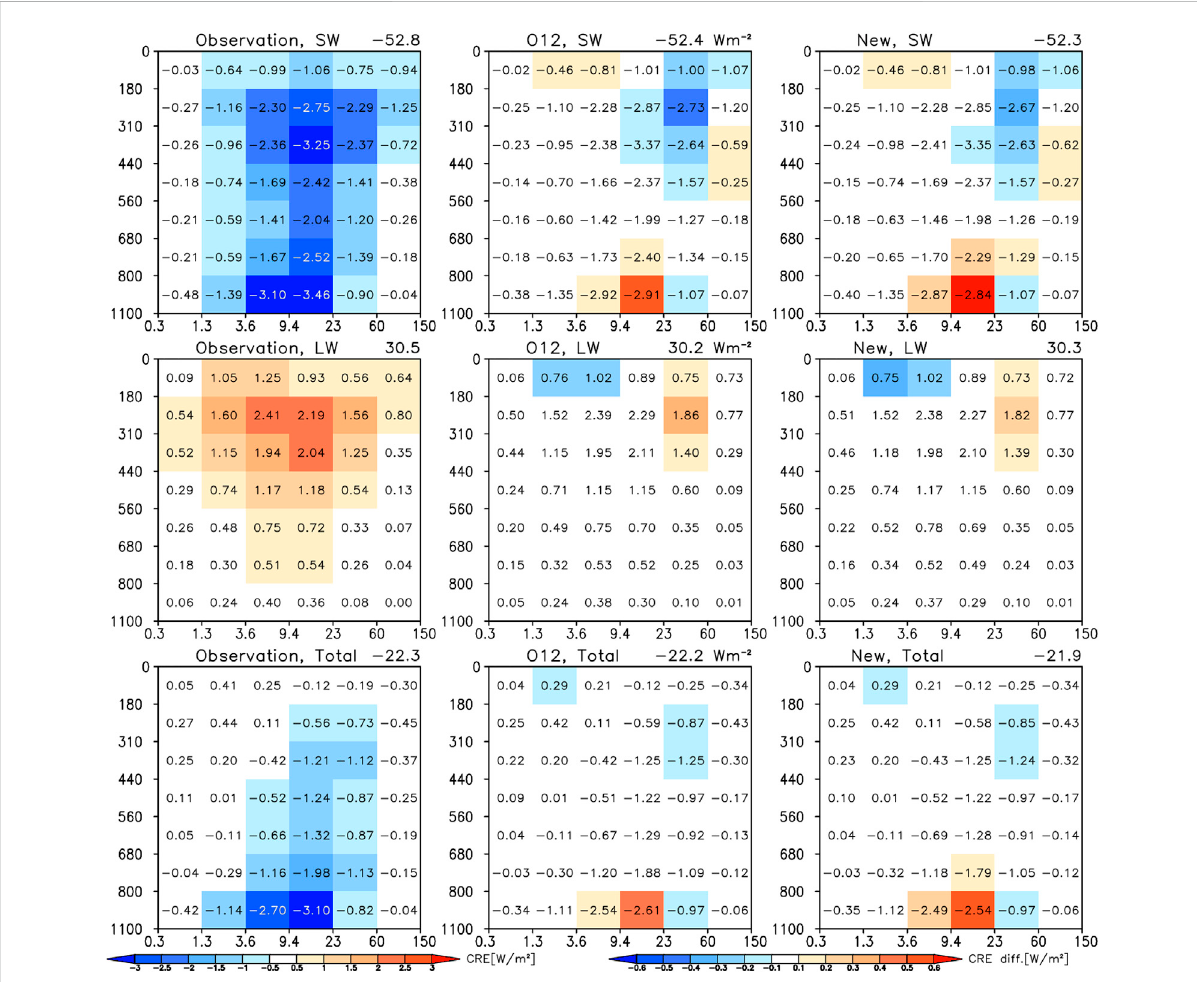
FIGURE 12 SW (top row) LW (middle row) and total = SW + LW (bottom row) CRE discretized by combinations of CTP-TAU bins when using CF joint histograms from observations,and theRaisanengenerator with either theO12decorrelationlengthparameterization ortheparameterizationofthis paper. The colors in the left column correspond to the actual CRE binned values numbers while in the other two columns to differences from